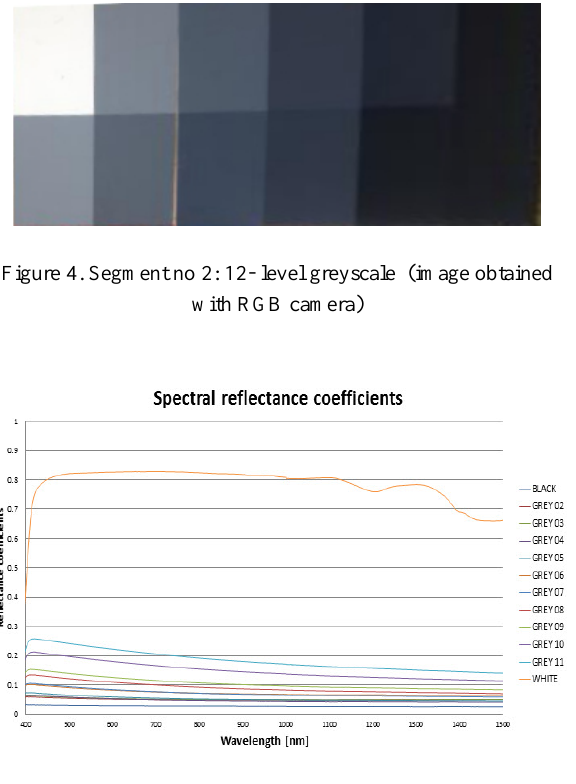
Figure 5. Segment no 2: Spectral reflectance coefficients of 12